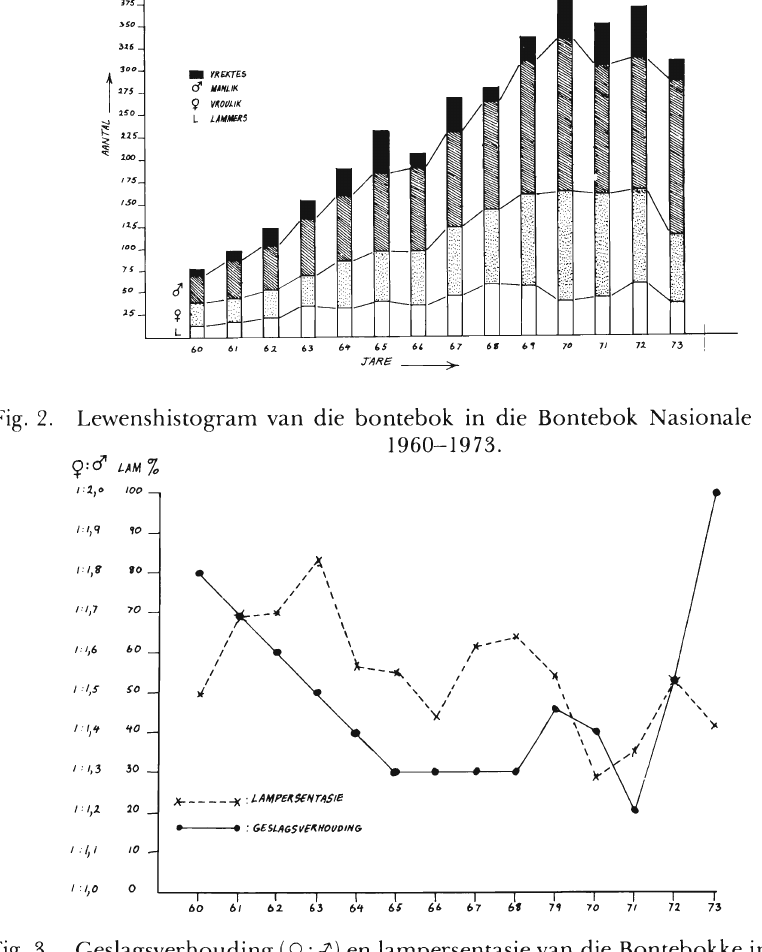
Fig. 3. Geslagsverhouding (9 :0') en lampersentasie van die Bontebokke in die Bontebok Nasionale Park